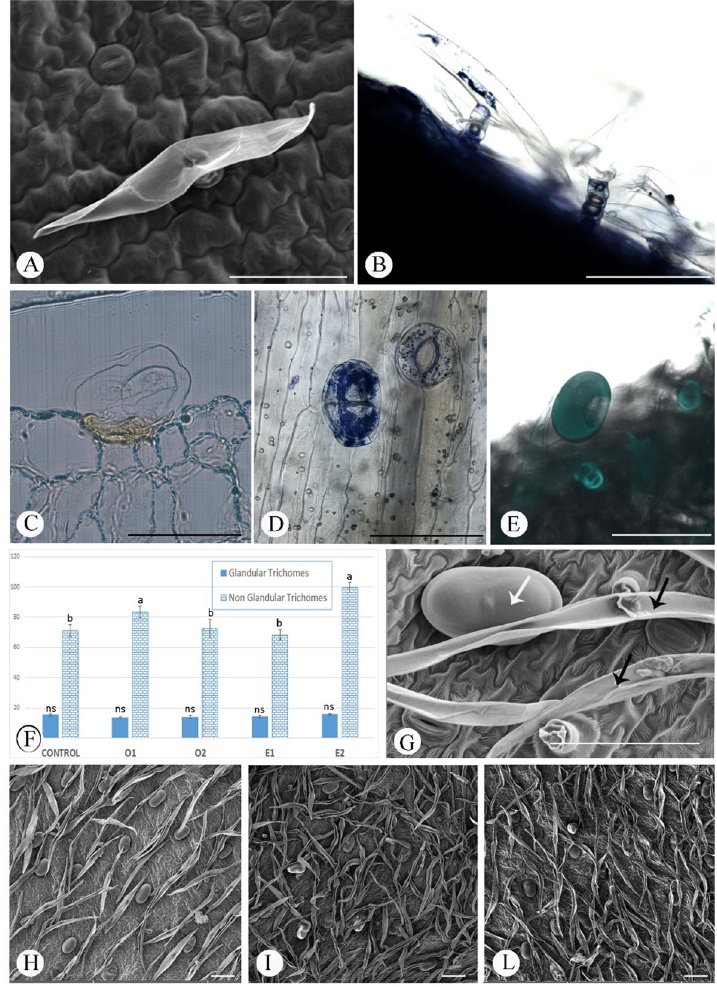
Figure 5. Trichomes in Tanacetum balsamita leaf. SEM ( A ) and Light ( B ) micrographs of non-glandular trichomes. Structural and histochemical features of glandular trichomes ( C – E ): ( C ) Light micrograph of a section of leaf; ( D ) The violet-blu stain produced by Nadi Reagent indicates the presence of terpens in the secretory cells and oil sac; ( E ) Fluorescence micrograph, the pale blue autofluorescence at the external edge of trichomes is due to the presence of wall-bound hydroxycinnamates; ( F ) Mean with SD of Glandular and non-glandular trichomes density in the different treatments: Control; O1 (OMW 2.5%); O2 (OMW 5%); E1 (EM 5%); E2 (EM 10%), different letters indicate a significant difference ( p < 0.05) according to Tukey’s test, ns non-significant. SEM micrographs ( G – L ) of tri- chomes: ( G ) glandular (white arrow) and non-glandular (black arrows) trichomes; ( H ) Control; ( I ) O1 treatment; ( L ) E2 treatment. Scale bars = 100